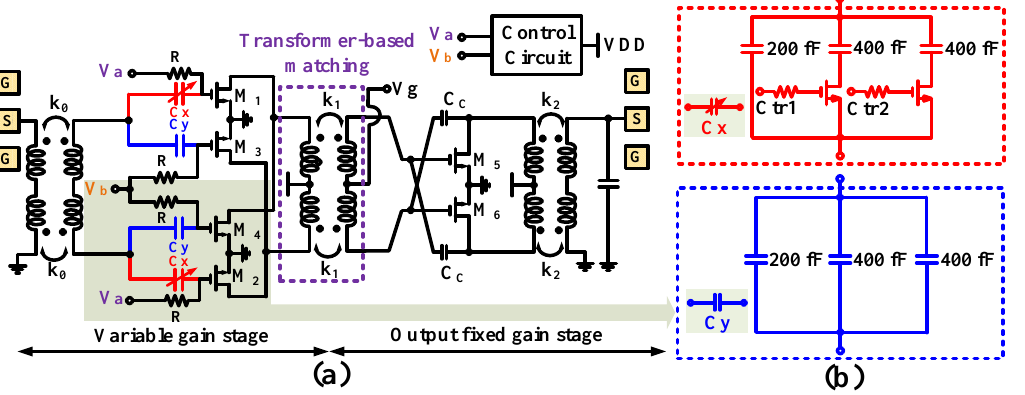
Figure 1. Commonly used mm-wave VGA structures: ( a ) classic current-steering VGA with two- stack transistor structure; ( b ) classic Gilbert-cell-based VGA with two-stack transistor structure; ( c ) proposed CS VGA with stackless transistor structure.